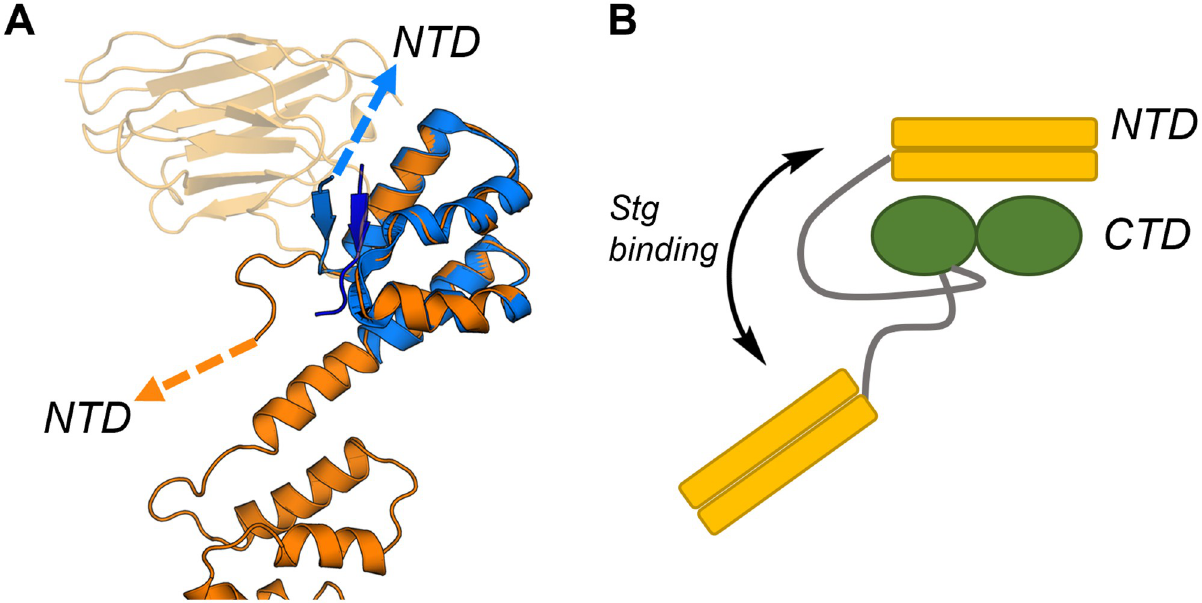
Fig 12. The potential effect of Stg binding on the structure of full-length Arc. A Alignment of the extended conformer of the hArc-CTD (orange), crystallised in complex with NbArc-H11 and -C11, and the isolated hArc-CTD N-lobe crystallised in complex with Stg (blue, 6TNO, [34]). NbArc-H11 is shown in transparent orange and the bound Stg in dark blue. The conformational change in the linker region is noted, by arrows pointing towards the NTD. B The hypothesised effect of Stg binding on the structure of linker region and the relative orientation of the two domains of Arc. The linker region is shown in